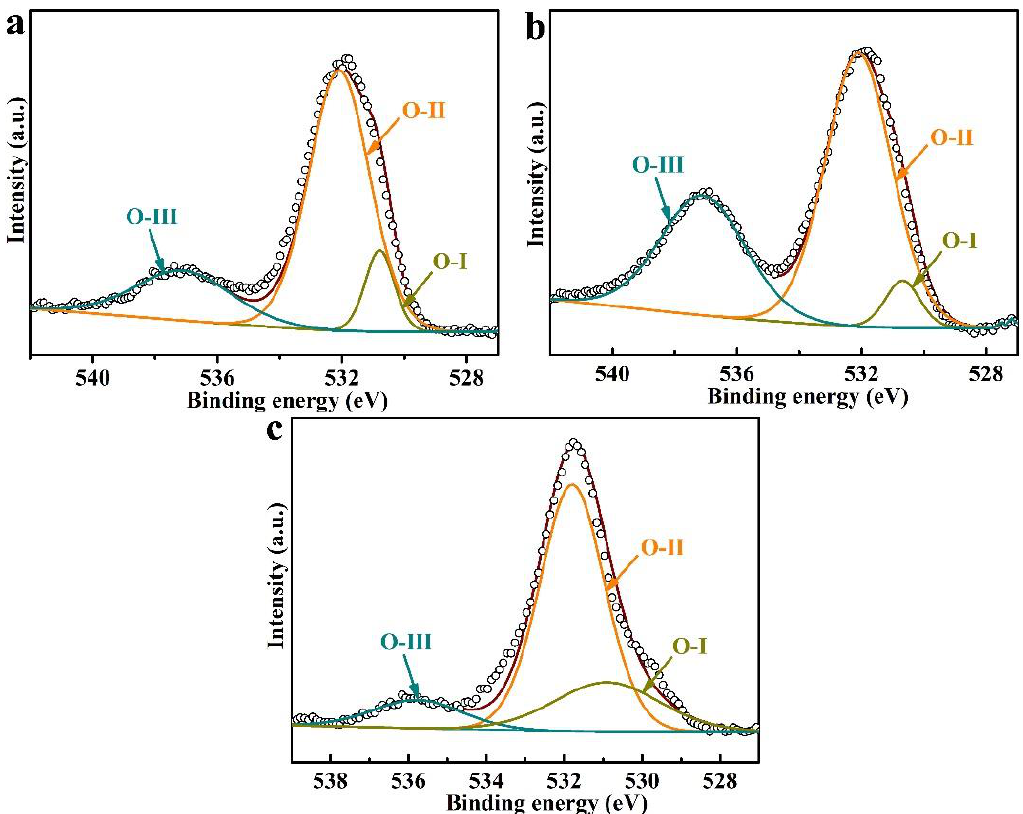
Figure 5. XPS O1s spectra of FEP films activated under different conditions: ( a ) FEP-THF-0.3 M-30 s, ( b ) FEP-DMI-0.9 M-30 min, ( c ) FEP-P.